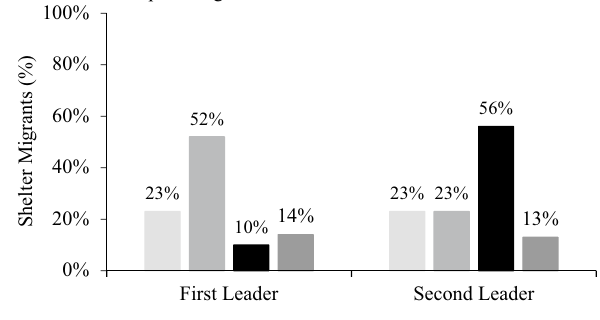
Figure 6. Sheltering by role (first and second leader) and wealth (equal budgets, first rich, second rich, and third